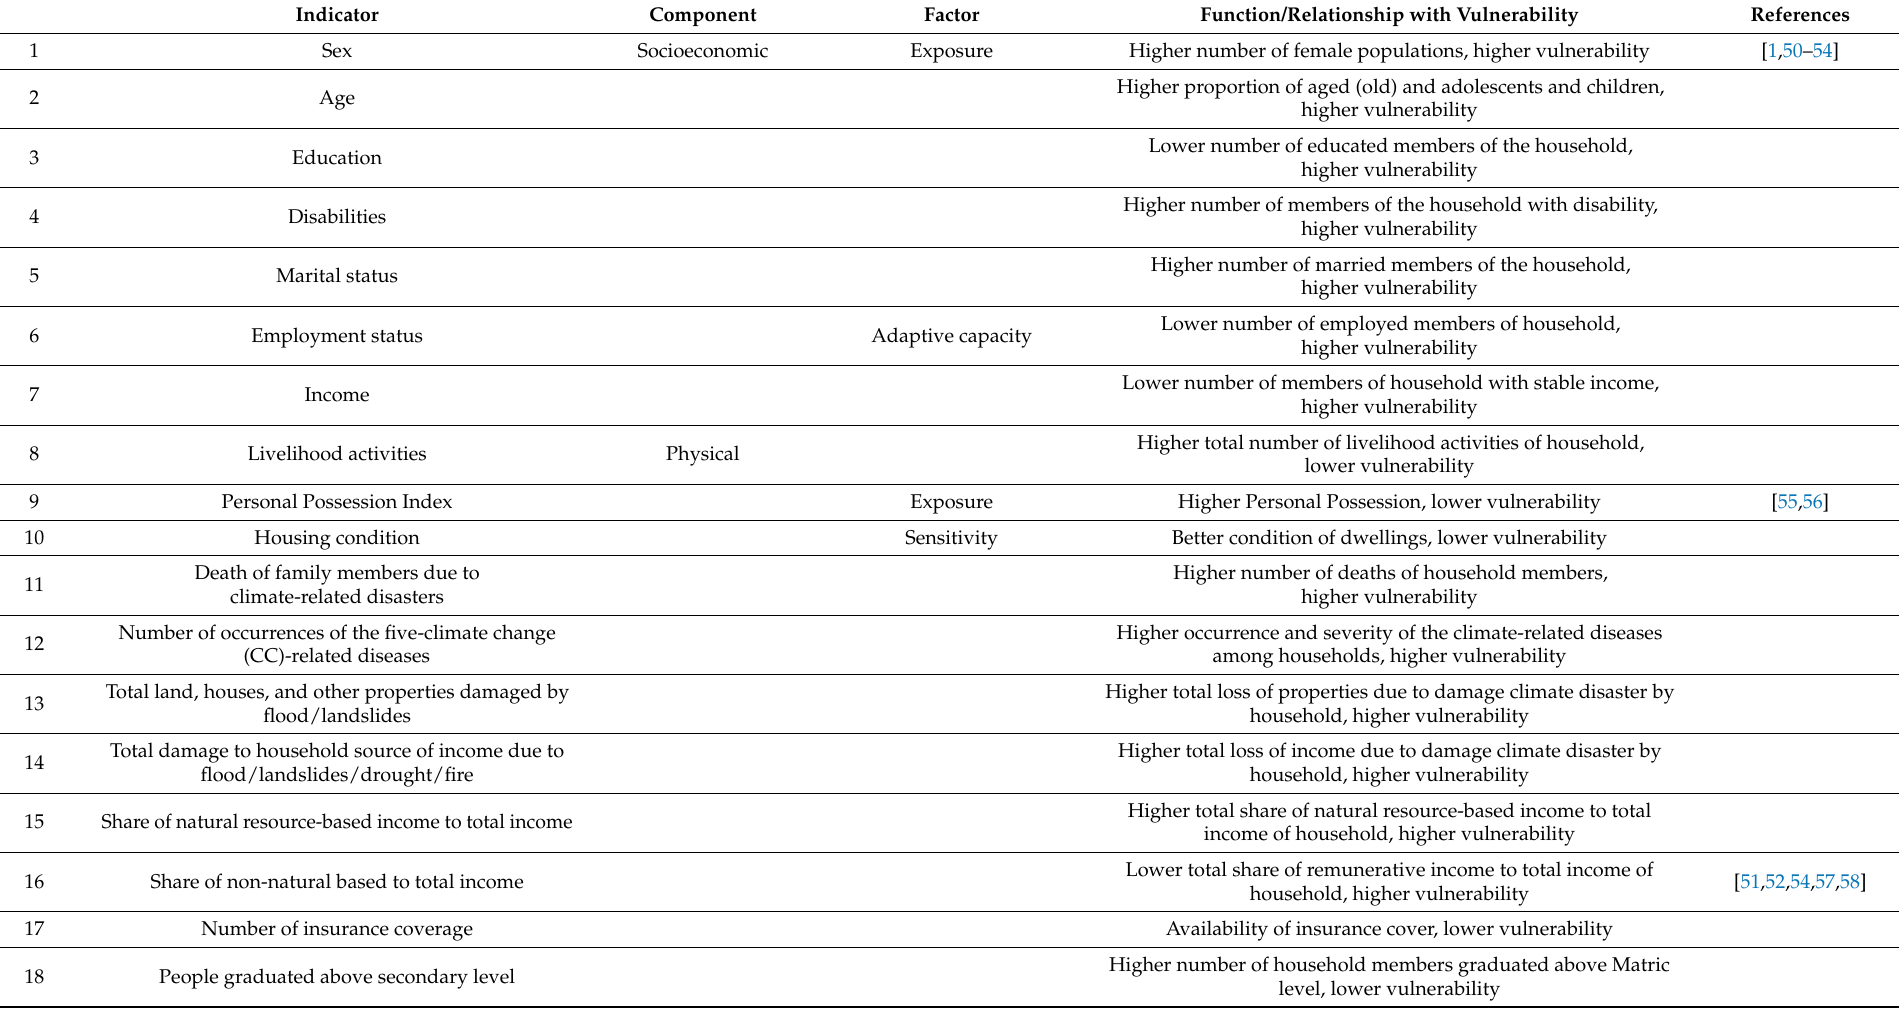
Table 1. Hypothesized indicators and their relationship with